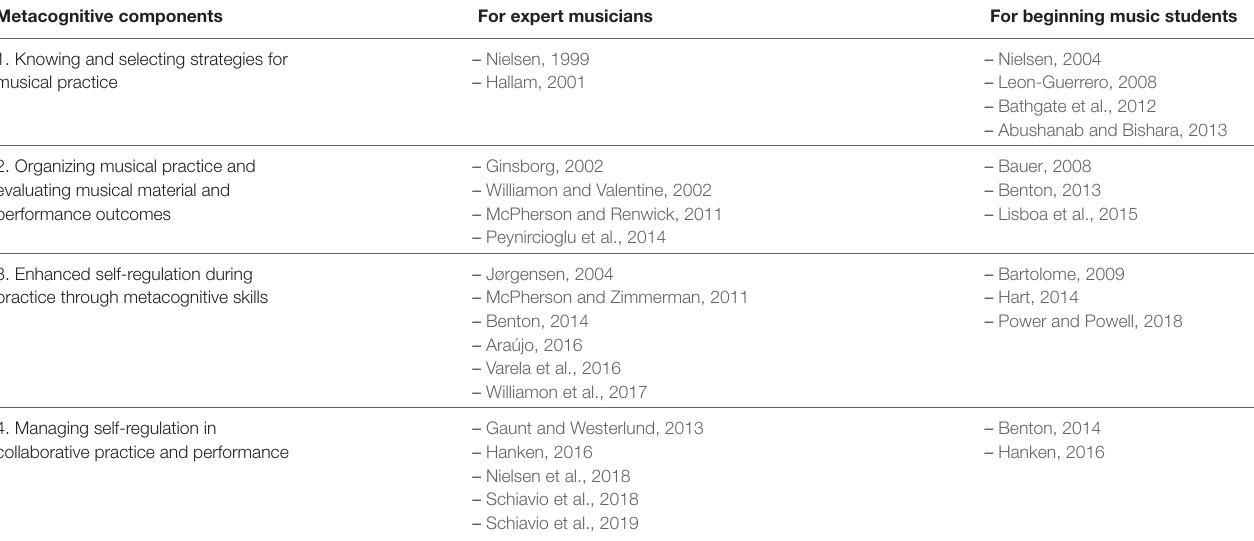
TABLE 1 | Summary of the main literature contributions in the research topic of music and metacognition. Metacognitive components For expert musicians For beginning music